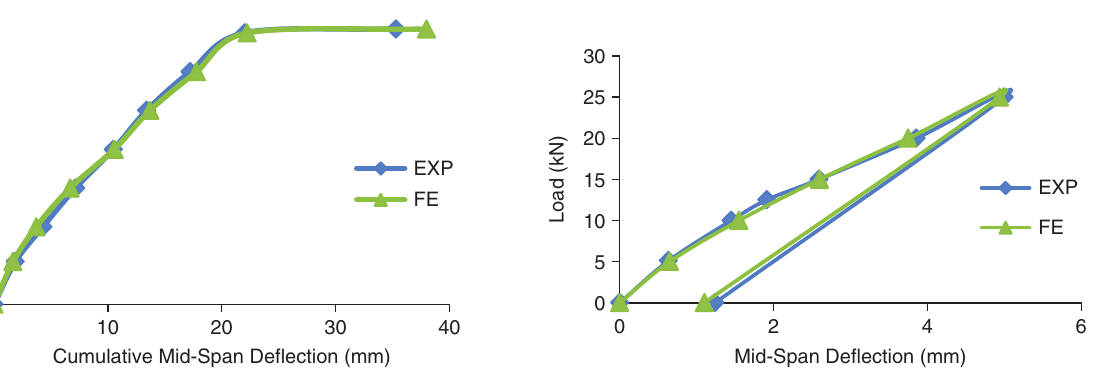
Fig. 11. Load against the de fl ection curve for pre-repair phase of the beam